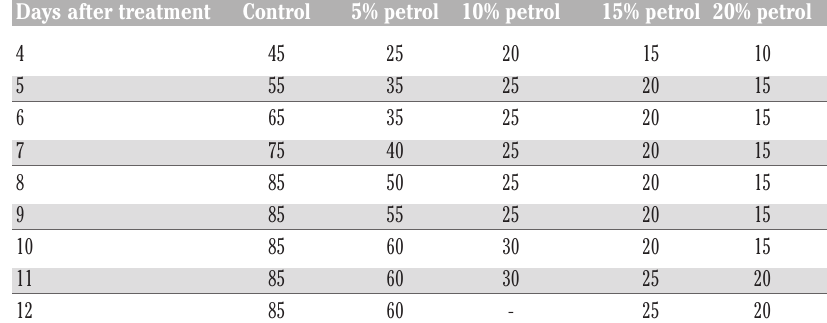
Table 1. Percentage germination of seeds of Guinea corn in different concentrations of petrol (in